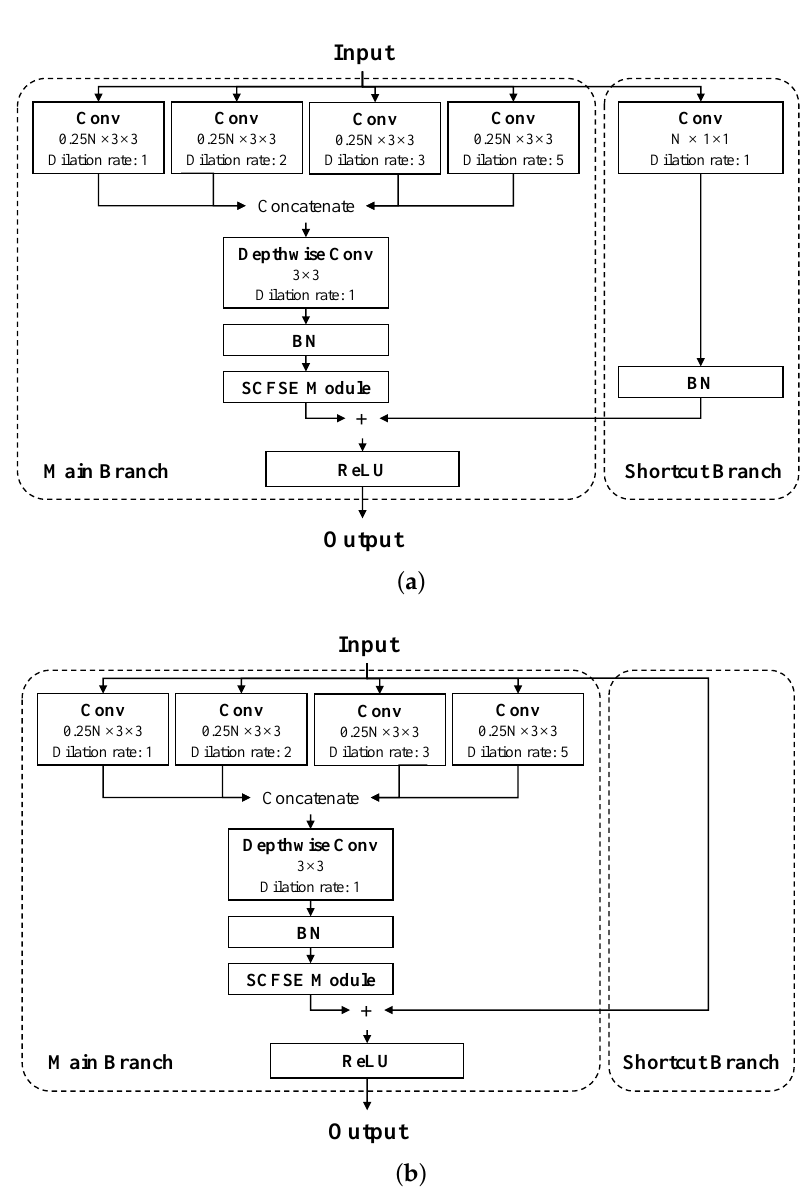
Figure 4. Structures of the Hybrid Basic Convolutional (HBC) Block and the Identity Mapping Hybrid Basic Convolutional (IMHBC) Block. ( a ) Hybrid Basic Convolutional (HBC) Block; ( b ) Identity Mapping Hybrid Basic Convolutional (IMHBC)